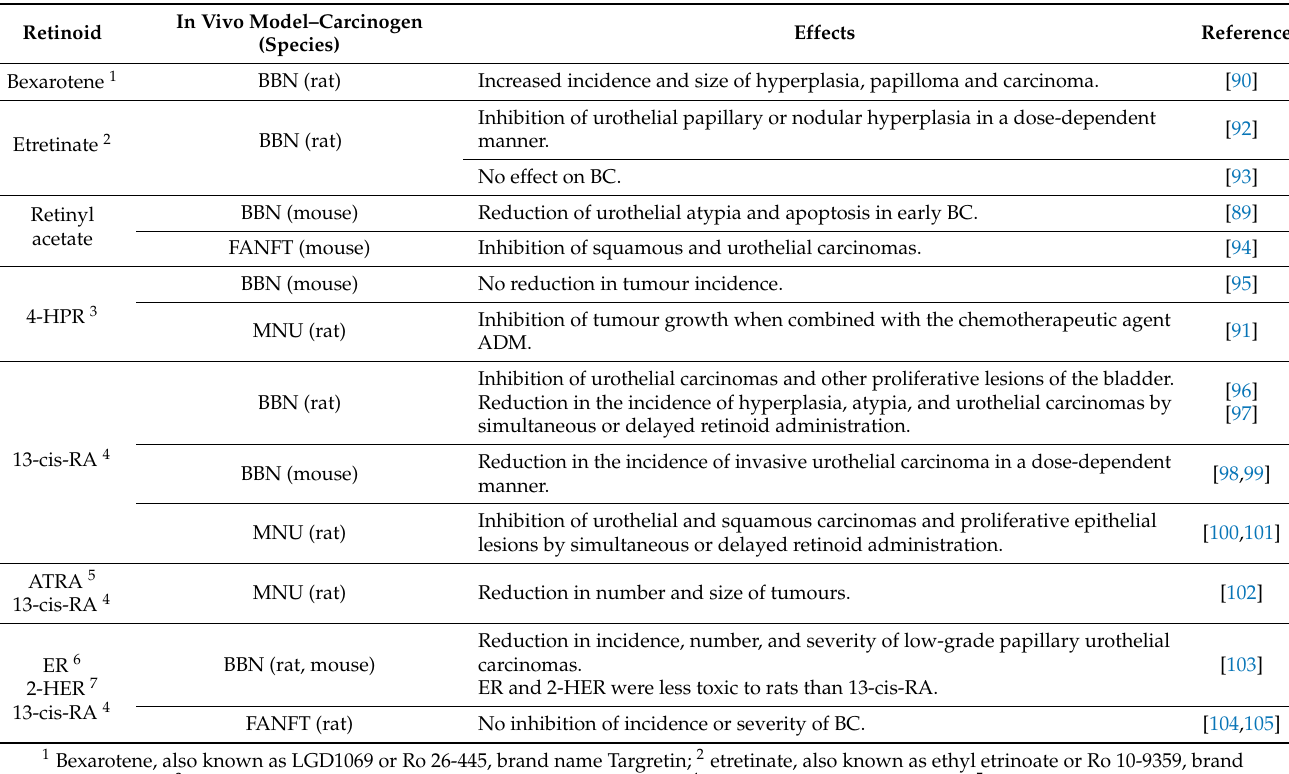
Table 2. In vivo studies investigating the effects of retinoids in carcinogen-based animal models of BC. In all experiments listed here, animals were fed with retinoid-supplemented diets. Retinoid